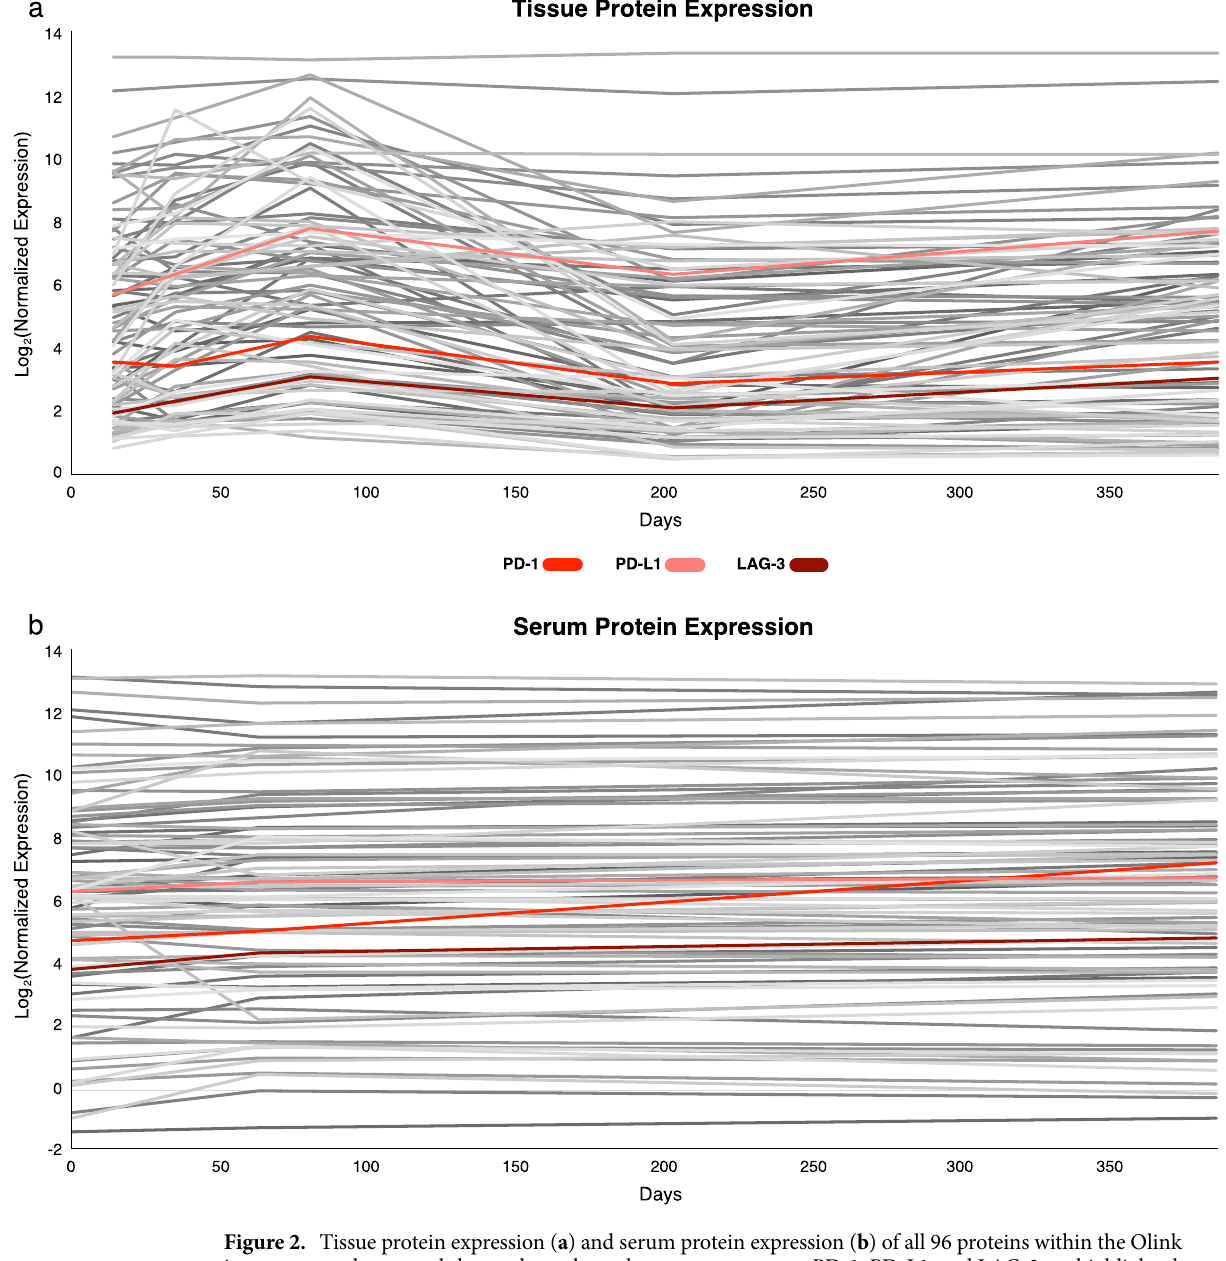
Figure 2. Tissue protein expression ( a ) and serum protein expression ( b ) of all 96 proteins within the Olink immuno-oncology panel shown throughout the treatment course. PD-1, PD-L1, and LAG-3 are highlighted within the